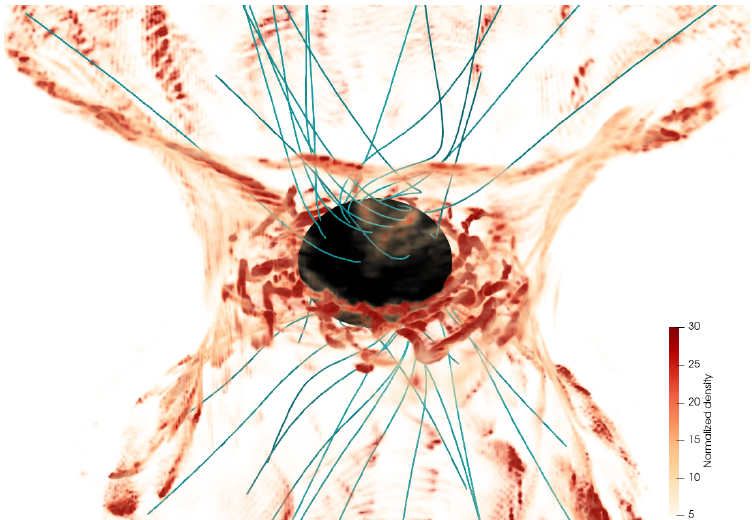
Figure 5. 3D general relativivistic particle-in-cell simulations (GRPIC) of a rotating black hole magnetosphere. Snapshot of the normalized total plasma density (in brown) with some magnetic field lines (in blue) at t = 40 r g / c , showing a persistent fragmented equatorial current sheet where particles are accelerated by magnetic reconnection, very close to the black hole horizon (in black). Taken from